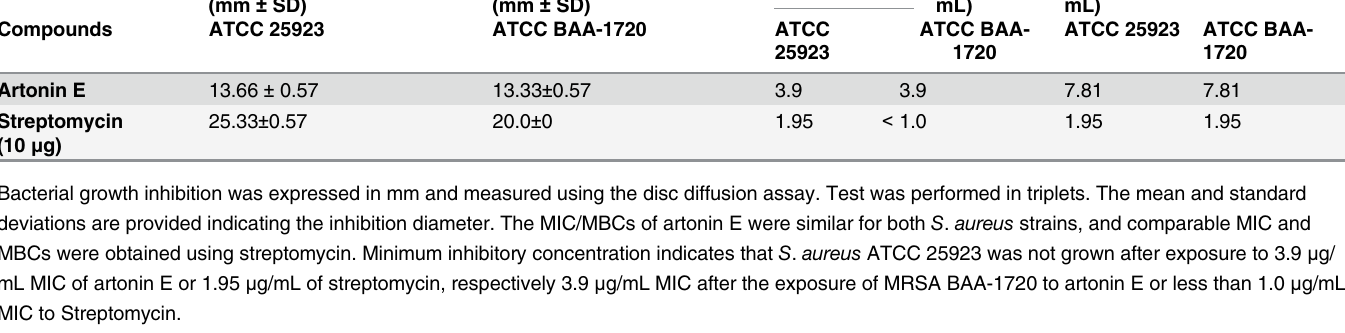
Table 1. Post-antibacterial effects of artonin E and streptomycin in Staphylococcus aureus ATCC 25923 and MRSA BAA-1720.